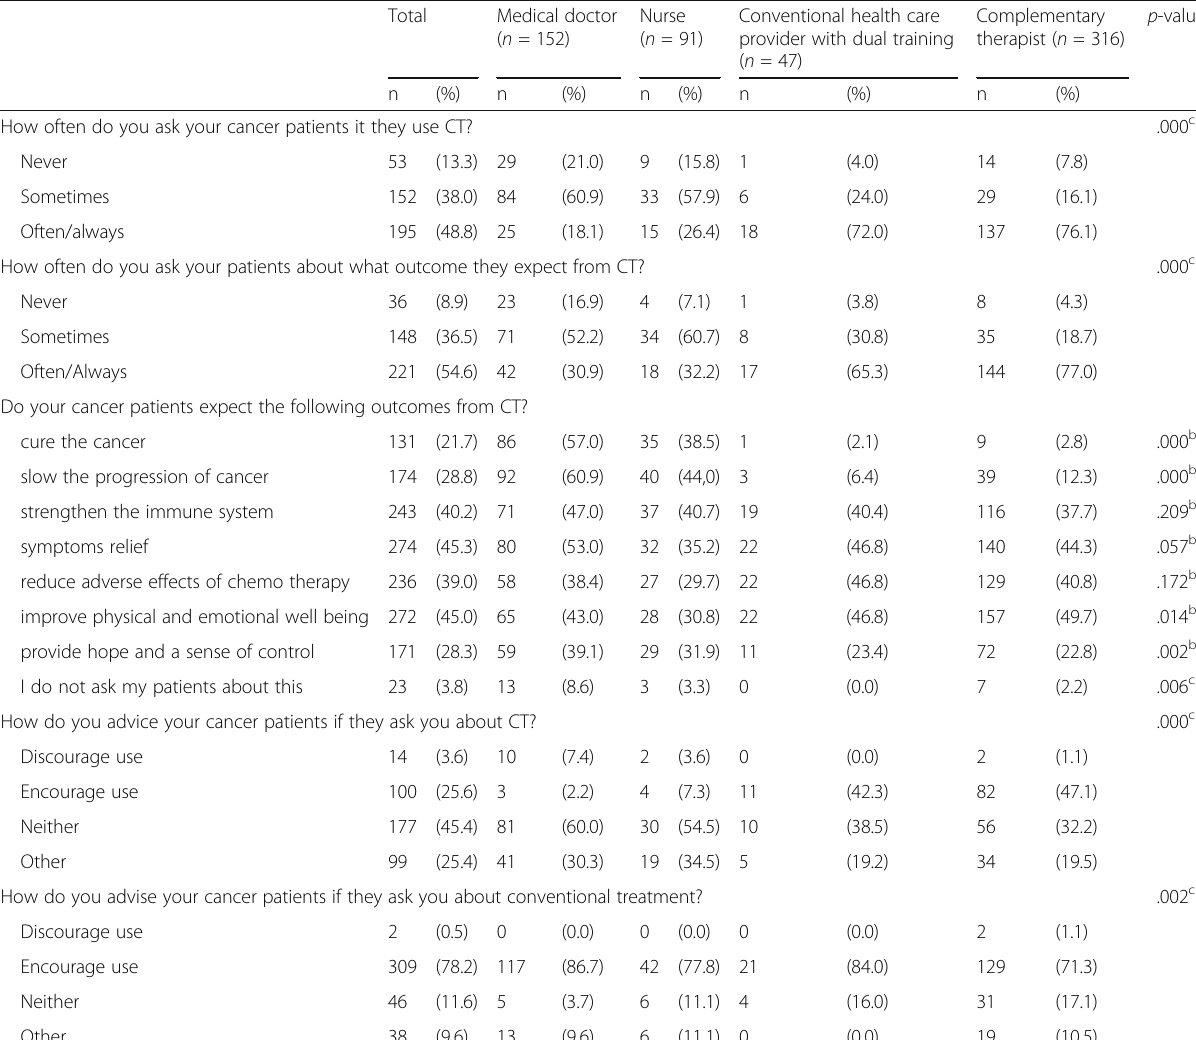
Table 4 Communication with patients ( n = 606)